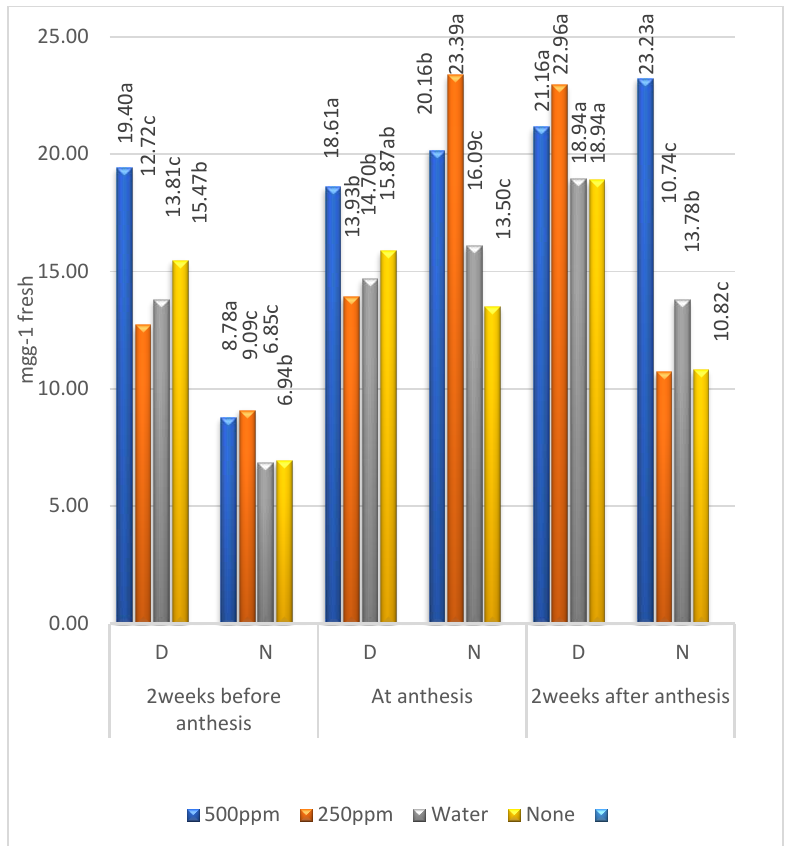
Figure 1. Combined means of soluble sugars for the levels of zinc under drought stress (D) and irrigation (N); means followed by the same letter in each environment are not significant at the 0.05 level of probability according to LSD test.